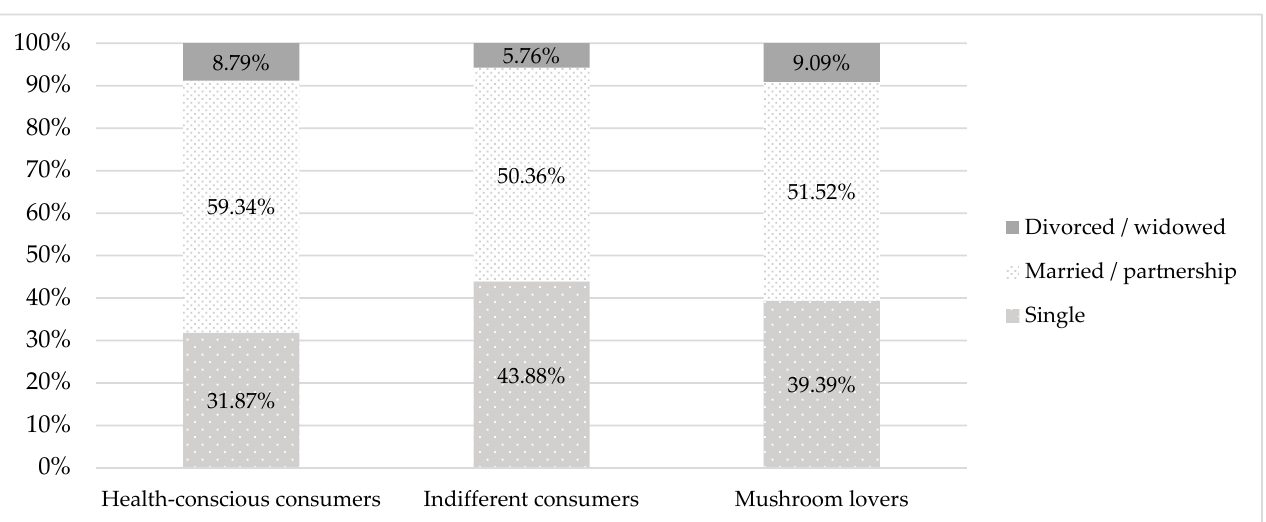
Figure 8. Distribution by location within clusters generated based on level of consciousness in mushroom consumption. In support of H3 the results confirm the impact of consumers’ age, education, and marital status on their mushroom consumer attitudes. 4. Discussion Several research related to food consumption habits [87–91,105] justified that con- sumer behavior differs by gender and other socio-demographic characteristics of respond- ents. The authors’ results are confirmed these findings. Based on the survey data obtained for Hungarian consumers, four dimensions of mushroom consumer habits were identified and are included in several food consumer models.